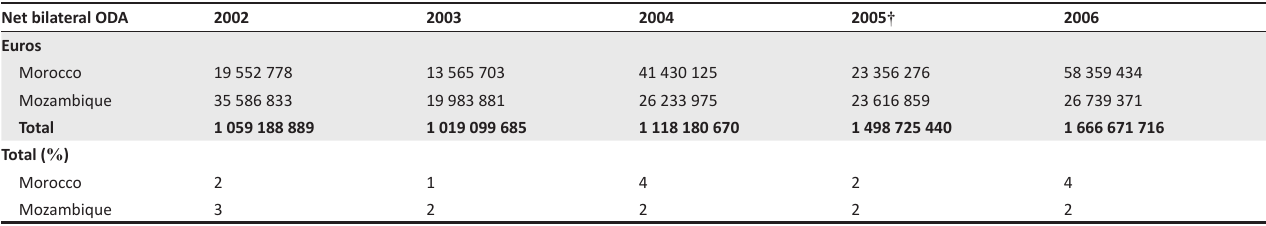
TABLE 1: Spanish bilateral official development assistance. Net bilateral